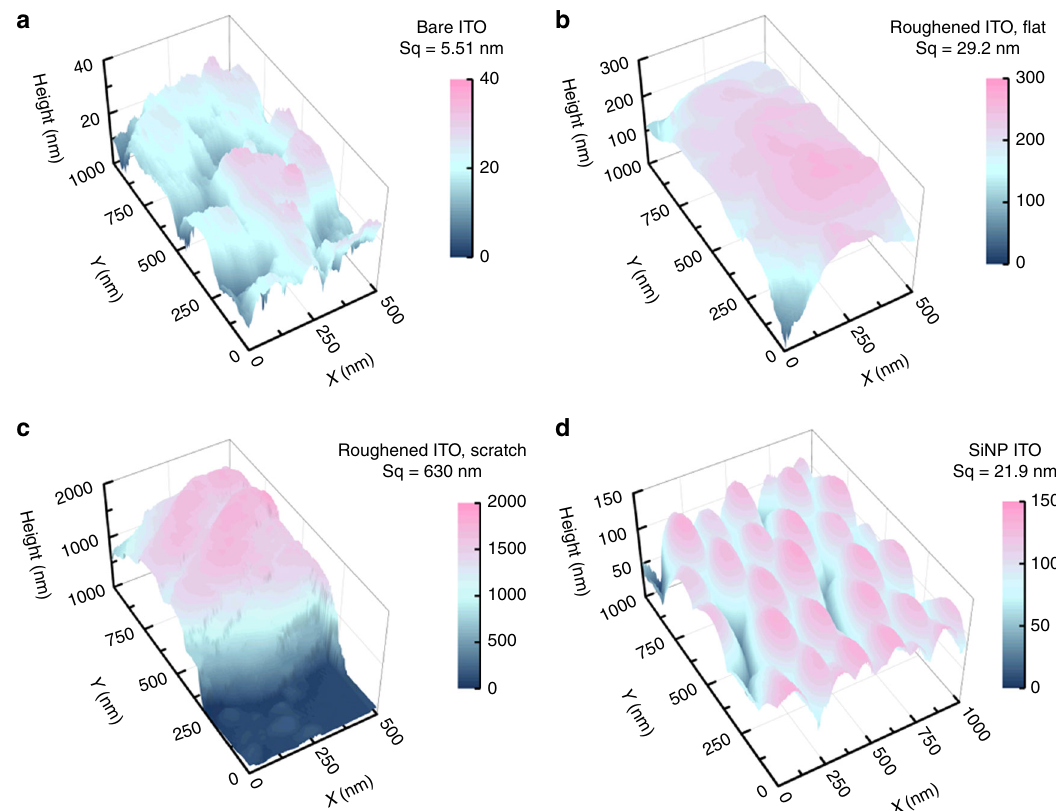
Fig. 7 3D surface morphology of the ITO surface. a Bare ITO. b A fl at region in roughened ITO. c A scratched region in roughened ITO. d SiO 2 NP-treated ITO. Sq denotes the root mean square height roughness.